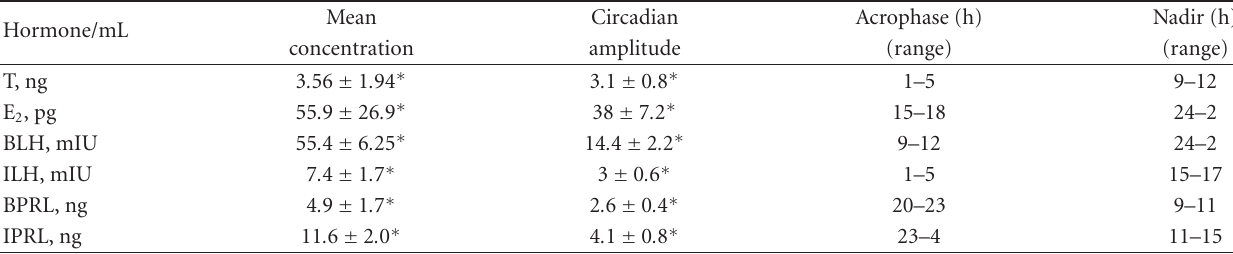
Table 5: Diurnal hormone variations in adult